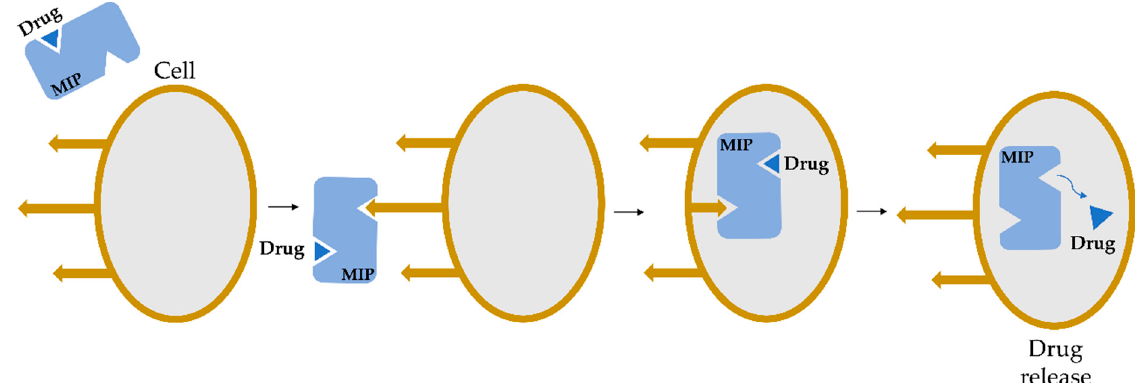
Figure 8. Scheme of targeted drug delivery into a cell with